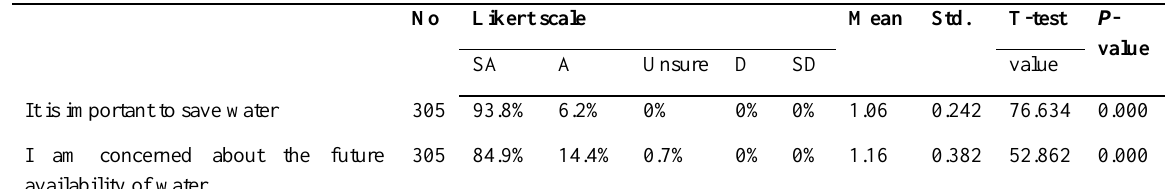
Table 6 : Respondents water conservation intentions